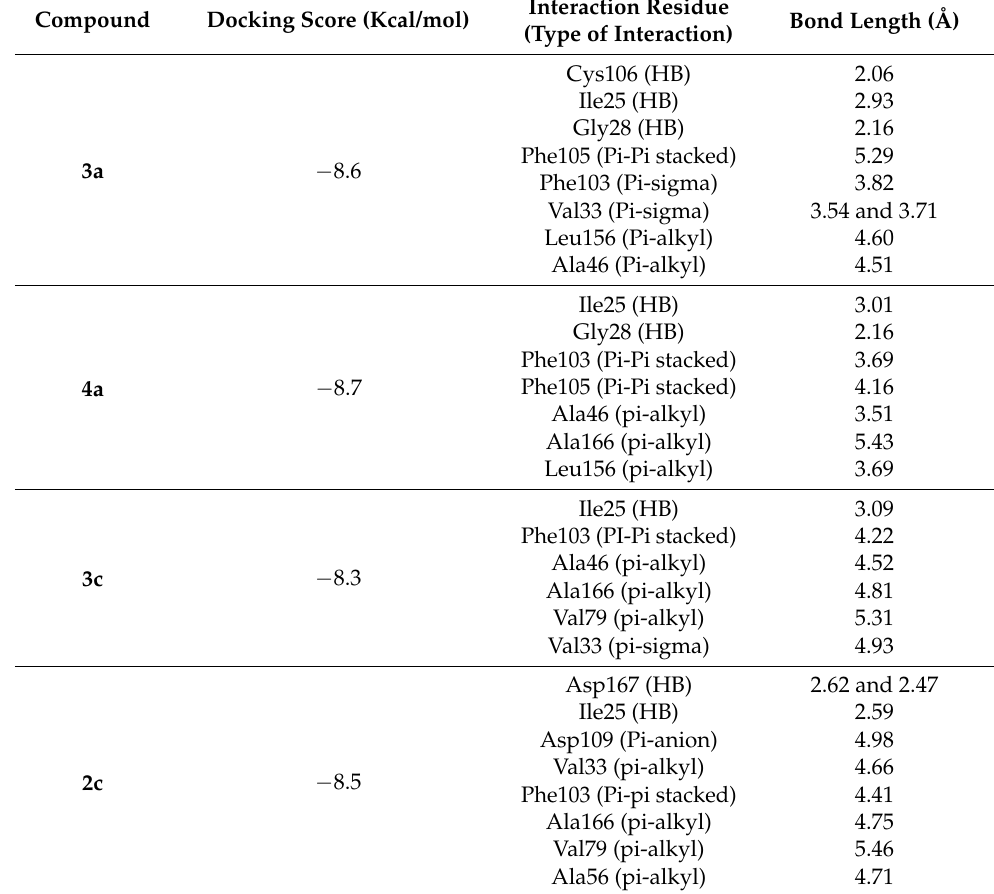
Table 4. Docking results of 3a , 4a , 3c , and 2c into the ATP binding site of CDK9.